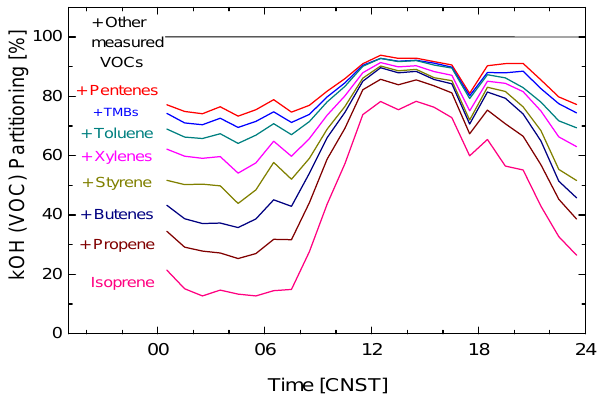
Fig. 6. Cumulative reactivities of measured hydrocarbons versus time of day, averaged for the days of 11–26 July 2006. The dom- inating VOC reactivities are displayed, normalized to the total re- activity of all measured hydrocarbons. The lowest (pink) line de- notes isoprene, the next line (brown) denotes isoprene + propene,